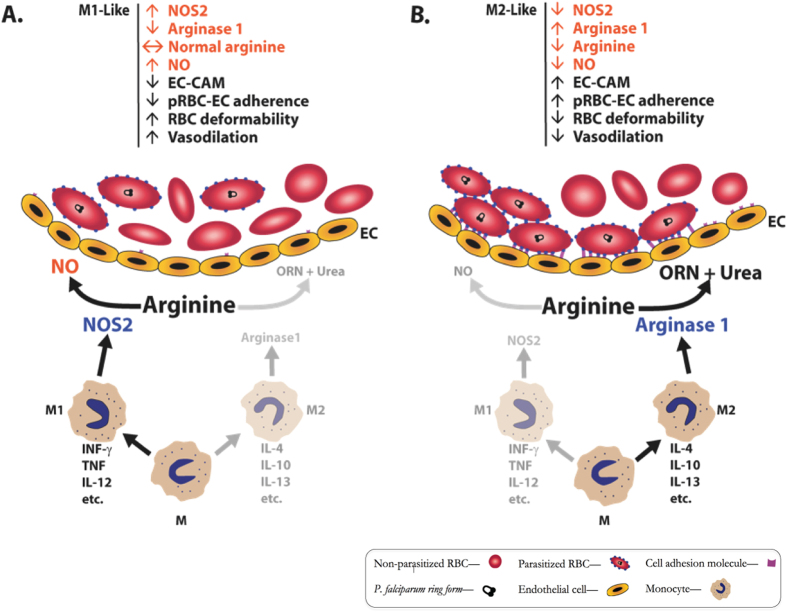
Schematic drawing depicting influence of M1 or M2 monocyte activation on arginase 1 and NOS2 expression, NO production, and adherence of parasitized RBC to endothelium.Monocytes (M) acted upon by various cytokines differentiate to (A) M1-like cells (“classically activated”) or (B) M2-like cells (“alternatively activated”). M1 cells can produce NOS2 that converts arginine to nitric oxide (NO) (A). M2 cells can produce arginase 1 that converts arginine to ornithine (ORN) and urea (B), causing depletion of arginine and reduction of NO. NO decreases expression of endothelial cell adhesion molecules (EC-CAM) (e.g., ICAM-1 and VCAM-1), and absence of NO or low NO causes increased CAM expression. RBC expressing P. falciparum-encoded proteins such as PfEMP1 bind to EC-CAM (B) causing blockage of blood flow and distal tissue ischemia. NO reduces EC-CAM expression, increases RBC deformability, and increases vascular reactivity.